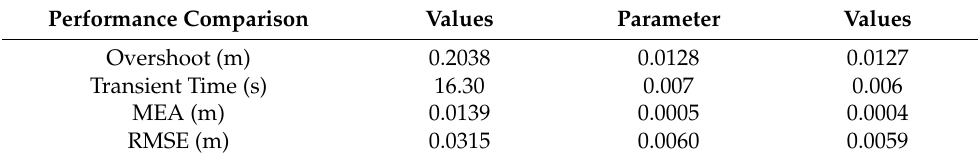
Table 3. Comparison of performance of different control schemes under